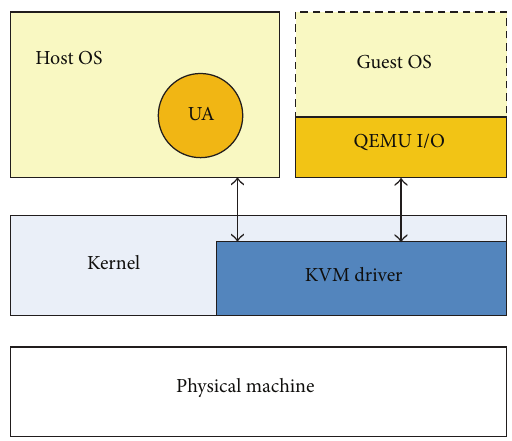
Figure 4: Mobile virtual